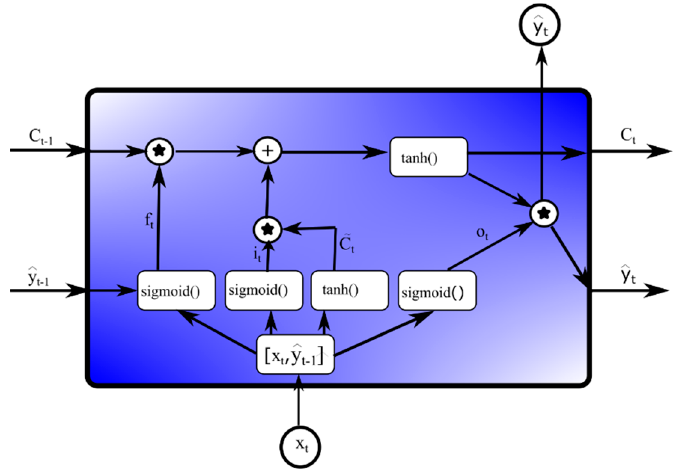
Figure 2. The structure of the long short-term memory (LSTM) unit.